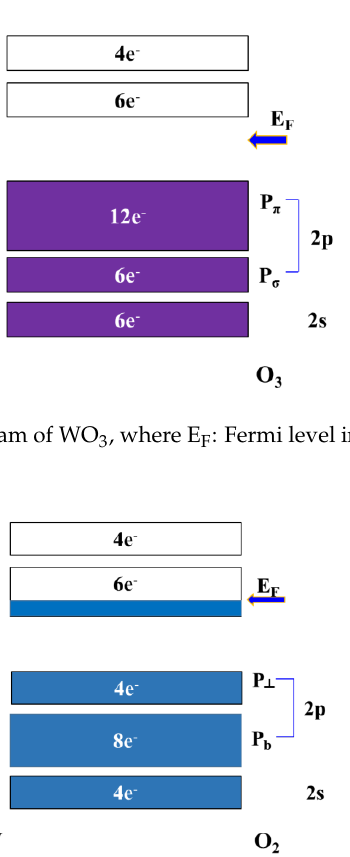
Figure 2. Schematic band profile of WO 2 , where E F : Fermi level in the location. Filled energy states are colored.